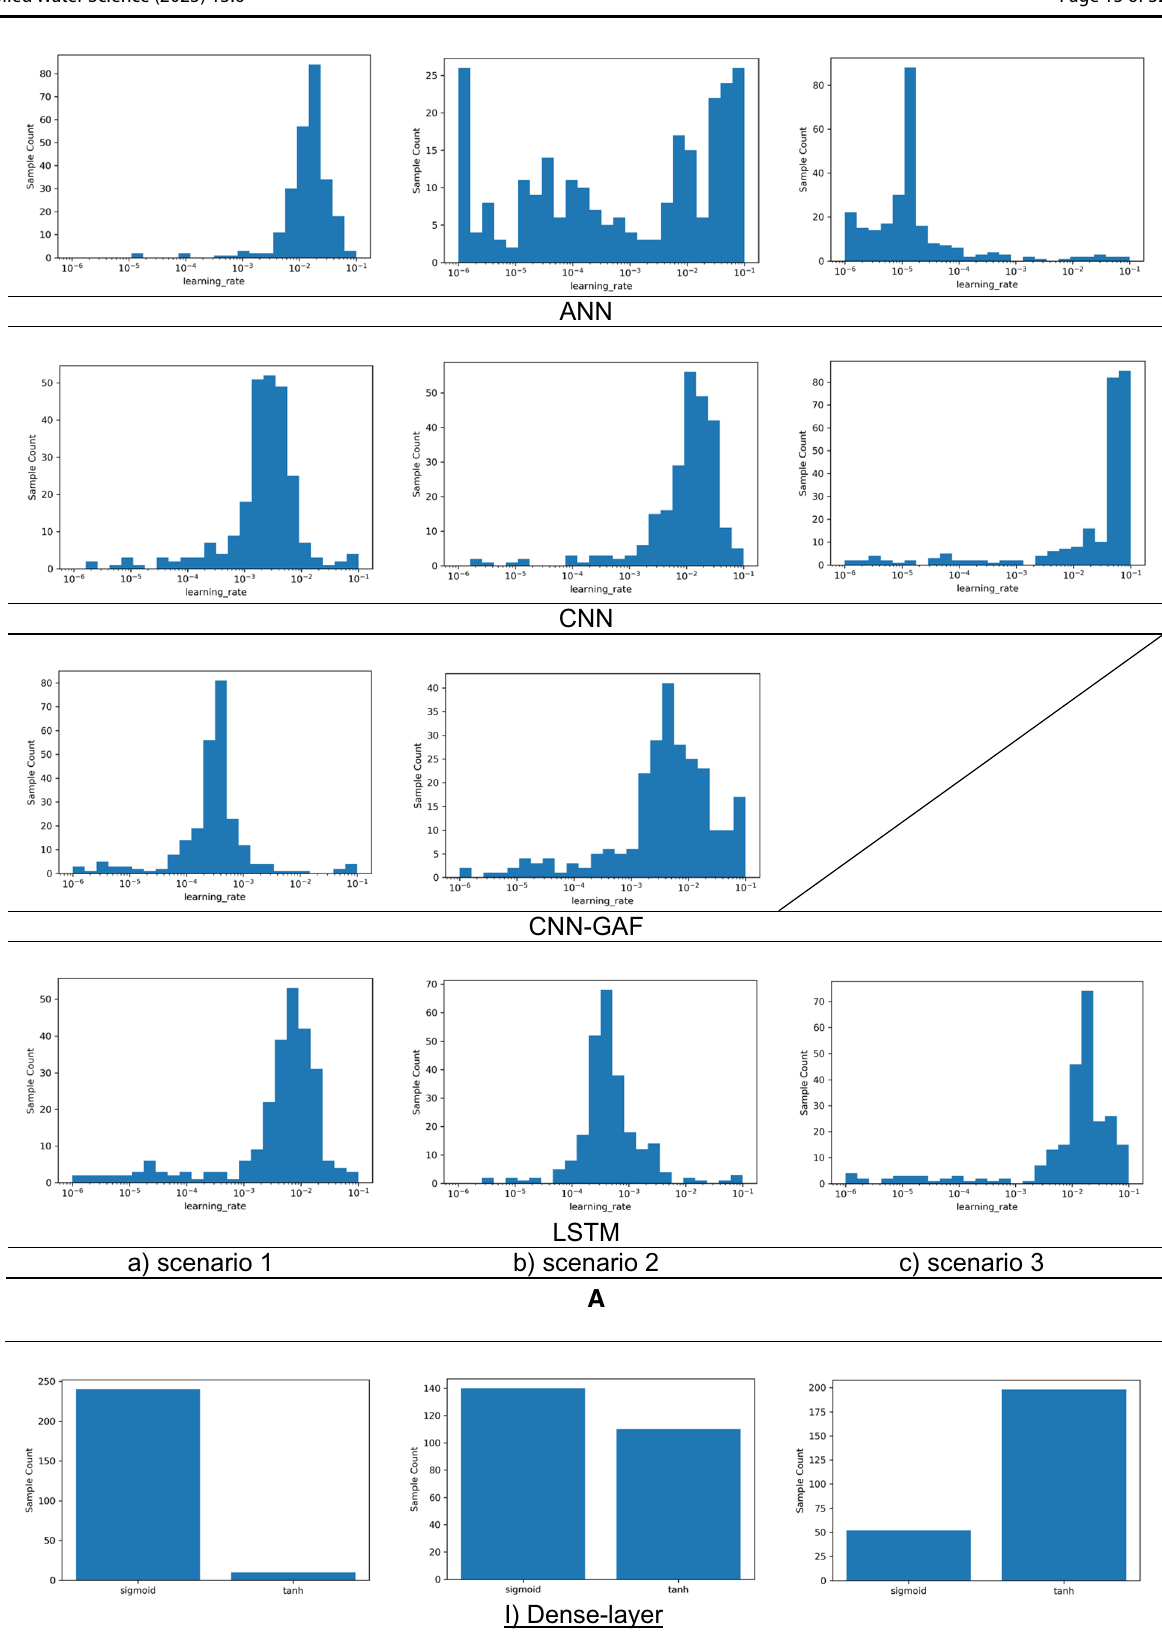
Fig. 8 Hyperparameter: a learning rate, b activation function, and c architecture size and neurons search domain of Bayesian